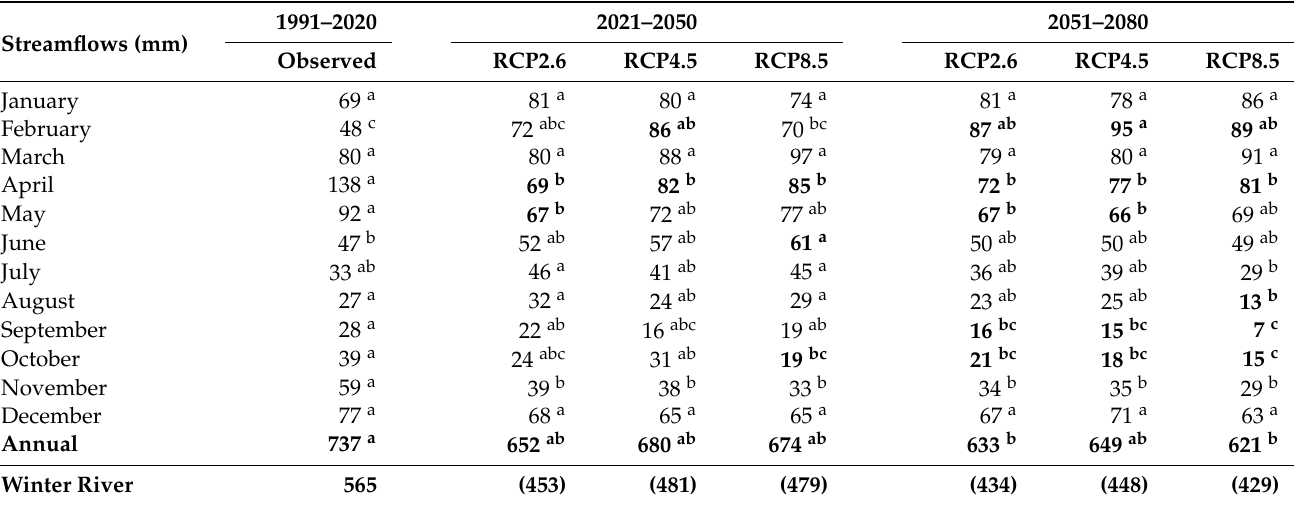
Table 10. Average streamflows (mm) observed in the central zone (at Riverdale and Suffolk of the West and Winter River watersheds, respectively) during the 2000s and modeled future projections during the 2030s and